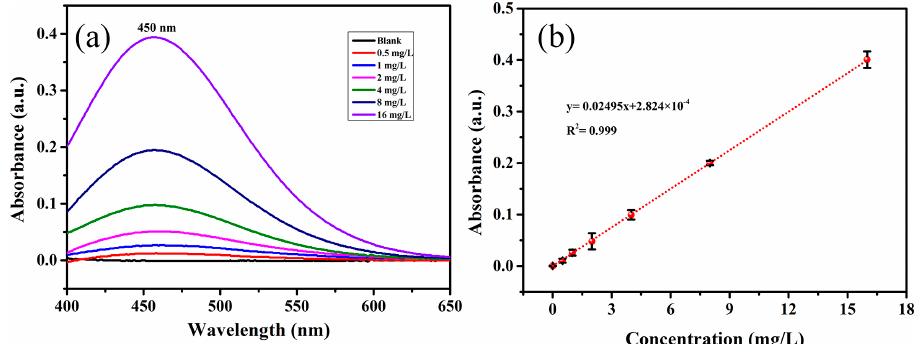
Figure 7. The detection of NaSCN in the milk via UV-visible absorption spectrometry (repeated three times). ( a ) UV-visible absorption of NaSCN with different concentrations in the milk. ( b ) The relation curve between the absorption at 450 nm and the concentration of NaSCN. Table 1. The concentrations of NaSCN in three milk samples (UV-visible absorption spectrometry vs. surface-enhanced Raman scattering (SERS)) (repeated for three times).